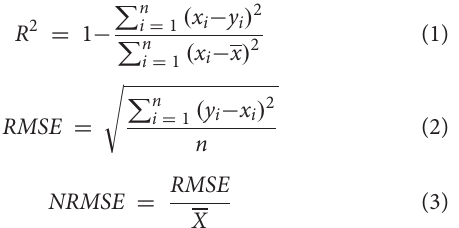
Frontiers in Plant Science |